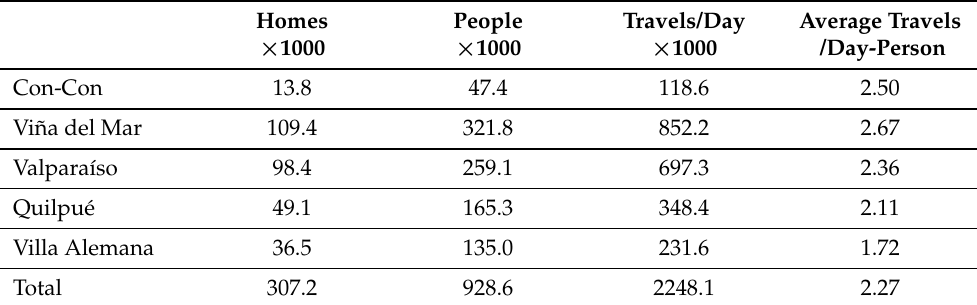
Table 6. Gran Valparaíso 2014–2015 O-D survey details.